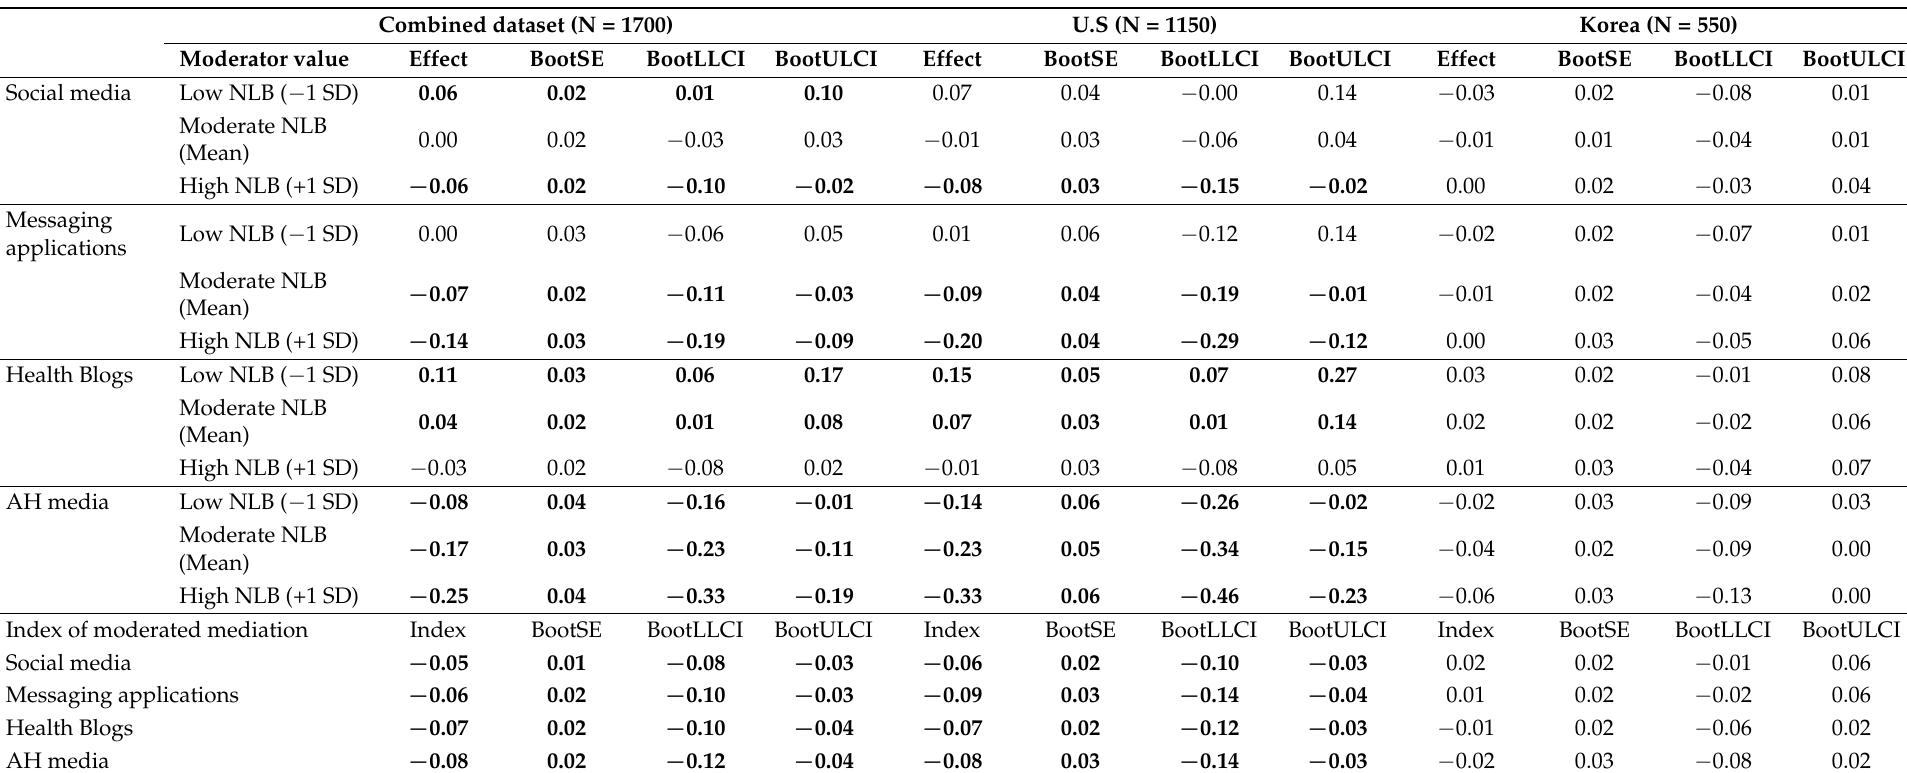
Table 5. The moderated mediation effect of media reliance for COVID-19 news on vaccination behavior. Combined dataset (N =